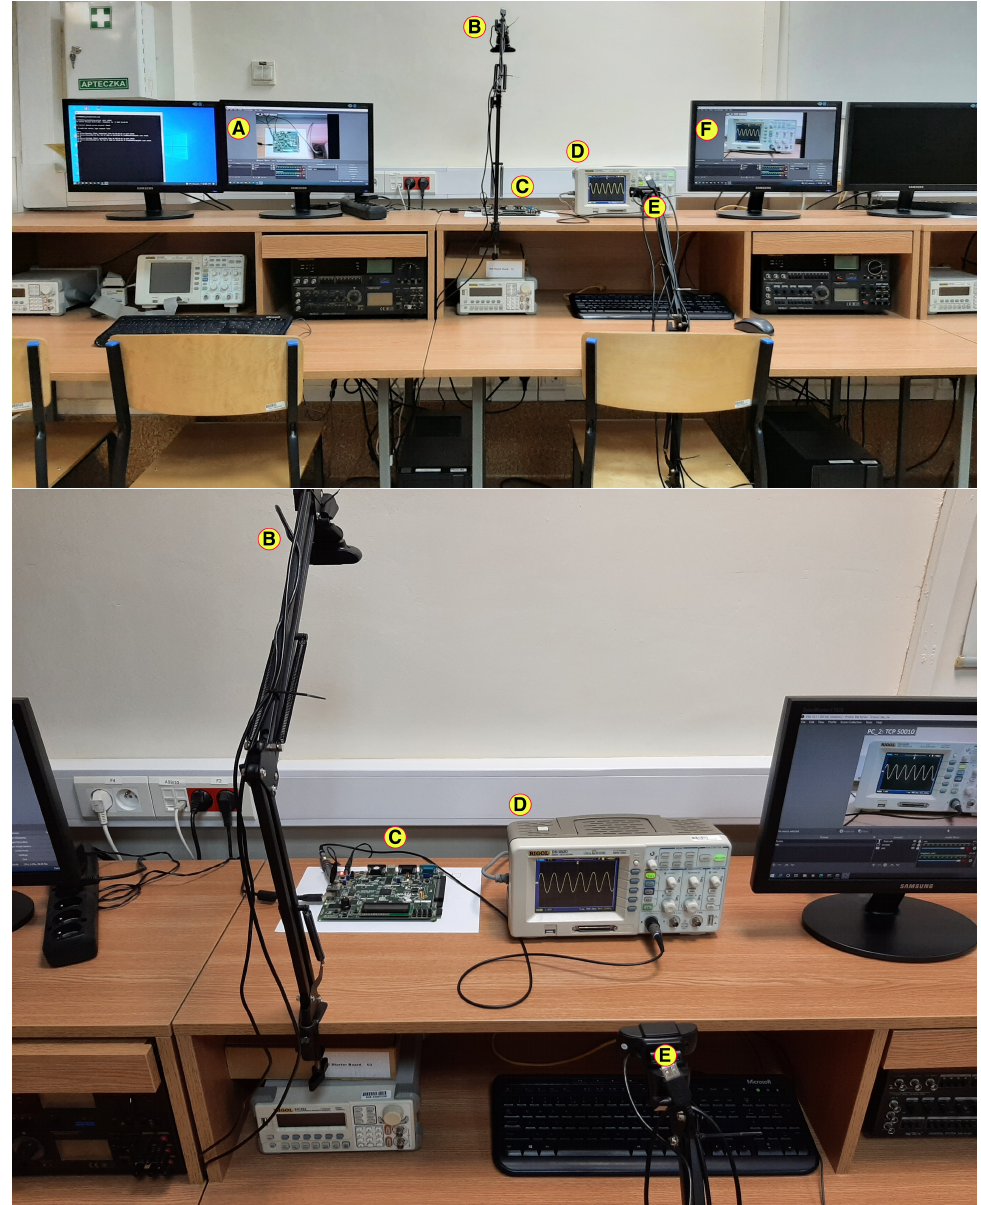
Figure 2. One lab stand behind the firewall in Figure 1. Computer A is connected to the FPGA test board C and camera B; oscilloscope D; and camera E is connected to computer